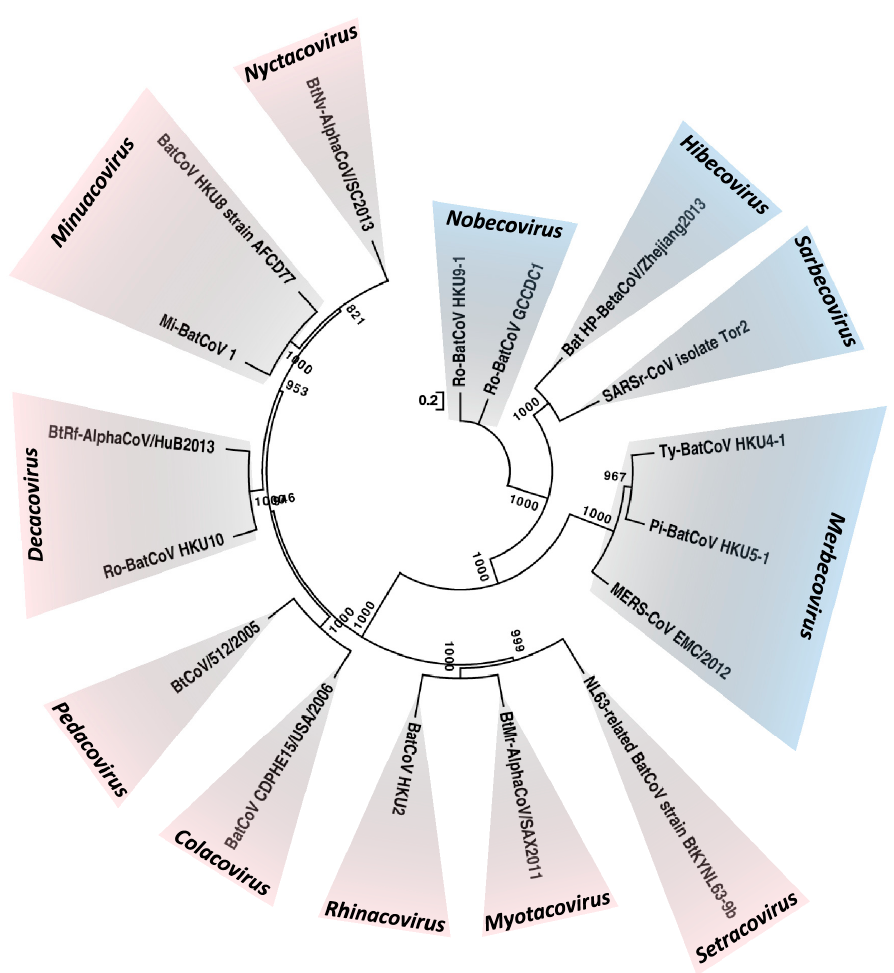
Figure 1. Maximum-likelihood phylogeny based on the complete genome sequences of 17 bat CoV species released by ICTV in 2018. A general time-reversible model of nucleotide substitution with estimated base frequencies, the proportion of invariant sites, and the γ distribution of rates across sites were used in the maximum-likelihood analysis. Bootstrap values are shown next to the branches. The scale bar indicates the number of nucleotide substitutions per site. Different colors represent different genera. Red, Alphacoronavirus ; blue, Betacoronavirus . Updated subgenera clusters are labelled Setracovirus, Myotacovirus, Rhinacovirus, Colacovirus, Pedacovirus, Decacovirus, Minunacovirus, Nyctacovirus for the Alphacoronavirus and Nobecovirus, Hibecovirus, Sarbecovirus, Merbecovirus for the Betacoronavirus .